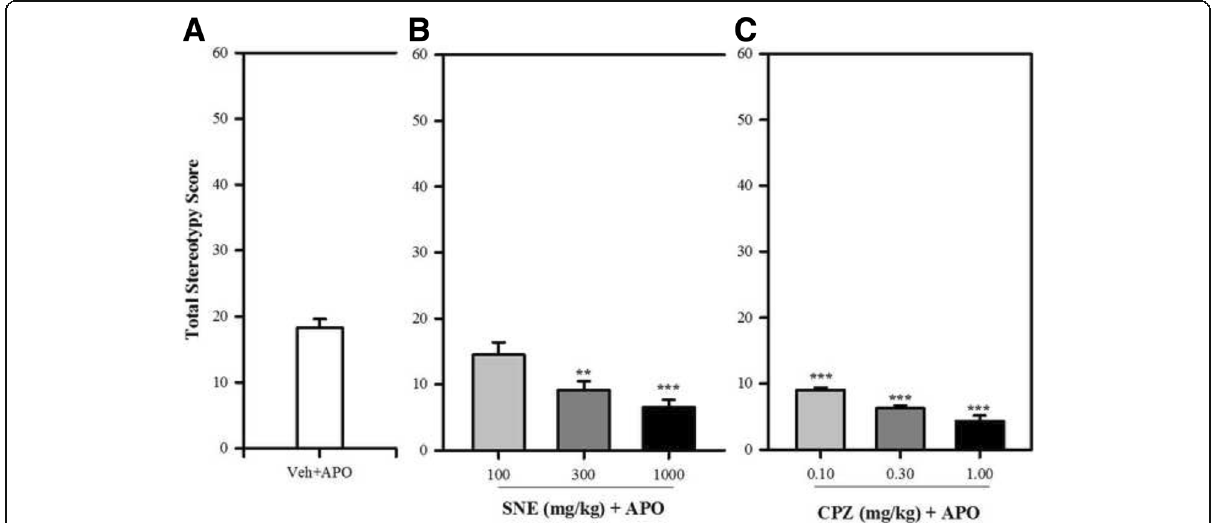
Fig. 5 Effect of SNE, CPZ and vehicle (Veh) (distilled water, 0.01 ml/kg, p.o) on the stereotypy score of mice pre-treated (30 min) with apomorphine (APO) (2 mg/kg, i.p). Data are mean ± SEM ( n = 5). * P ≤ 0.05, ** P ≤ 0.01, *** P ≤ 0.001 compared with Veh + APO group (one-way ANOVA followed by a Dunnett ’ s multiple comparison post hoc test)